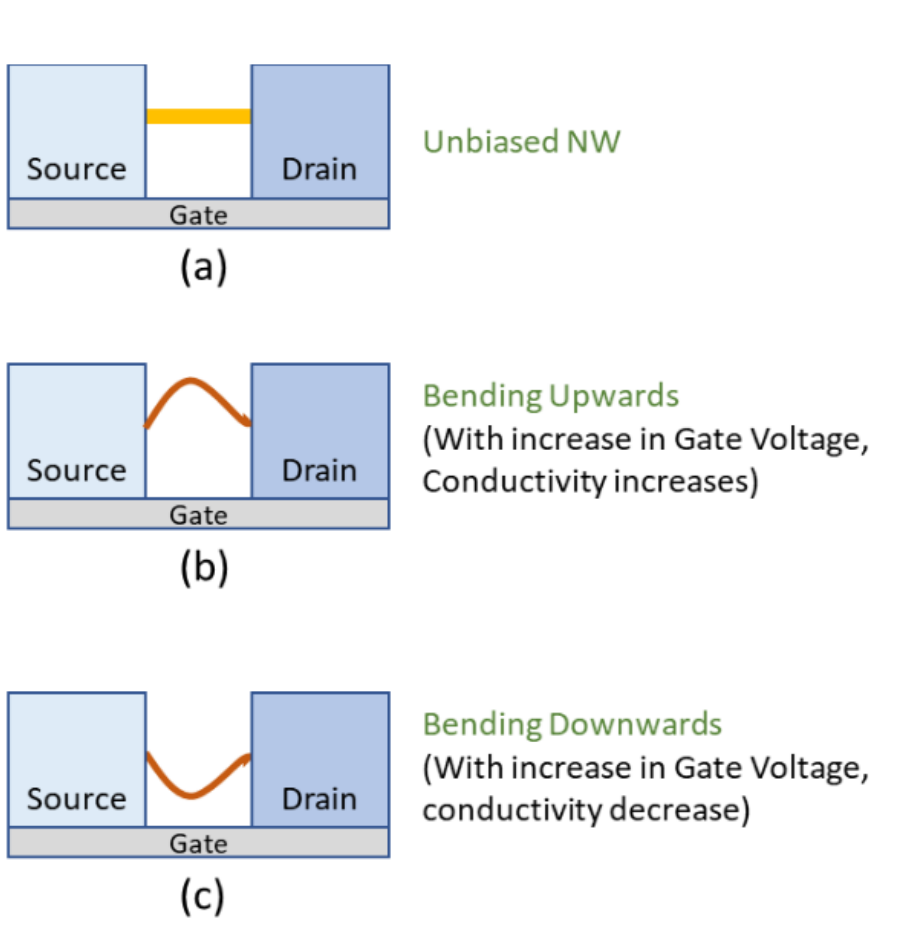
Figure 7. ( a ) Silicon (Si) nanowire (NW), ( b ) p ‐ type Si NW, and ( c ) n ‐ type Si NW.